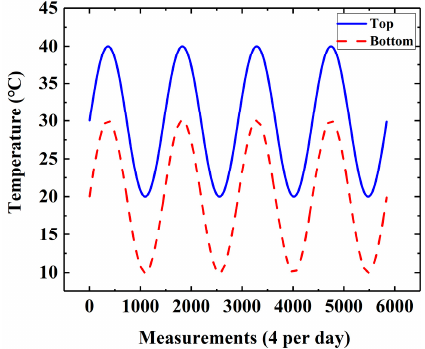
Figure 2. Evolution of temperatures at the top and bottom of the beam over four years.